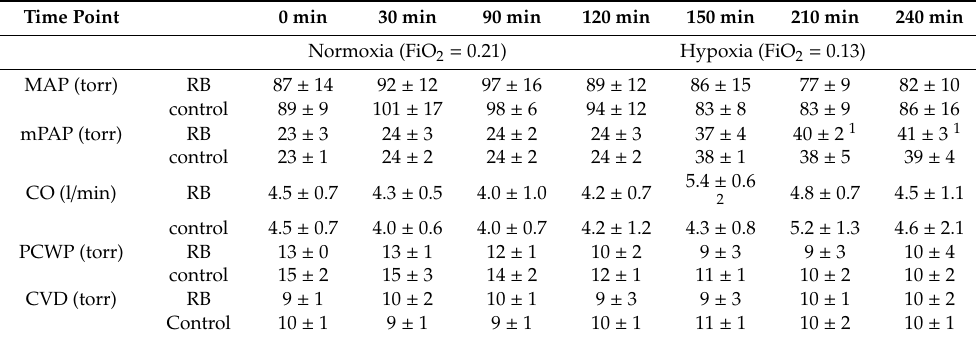
Table 1. Hemodynamic measurements ( n = 16).